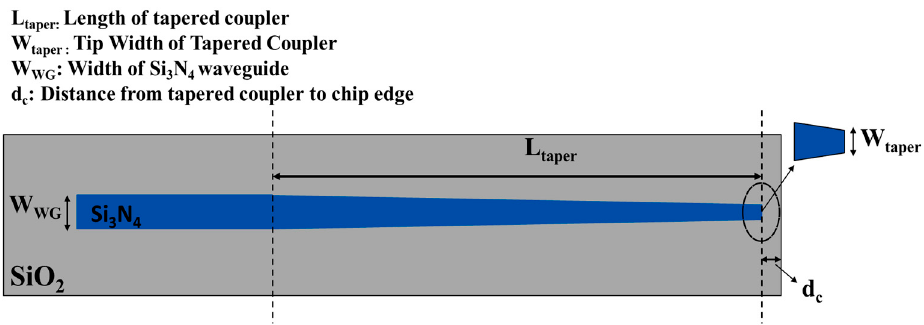
Figure 4. Schematic of inverse tapered edge coupler.